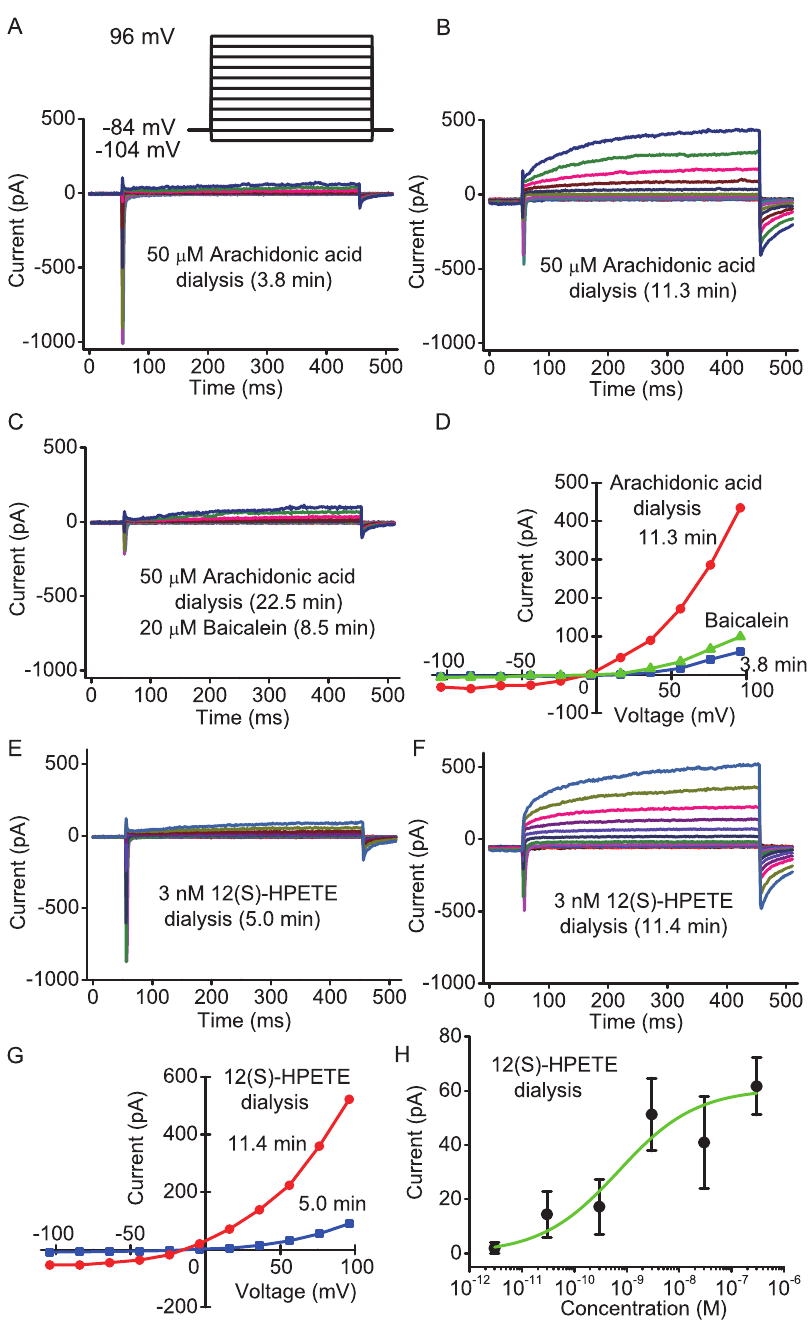
Figure 8. Biophysical properties of intracellular arachidonic acid-induced and 12(S)-HPETE-induced currents. (A) The currents elicited by 400 ms voltage steps between 2 104 to + 96 mV in 20 mV increments from a holding potential of 2 84 mV under the condition of 50 m M arachidonic acid dialysis after 3.8 min of the membrane rupture in normal saline solution. (B) The currents under same condition after 11.3 min of the rupture. (C) The currents under the condition after 8.5 min of the addition of 20 m M baicalein to external solution. (D) Current/voltage ( I/V ) relationships for the currents at the end of pulse in above conditions. (E) The currents under the condition of 3 nM 12(S)-HPETE dialysis at 5.0 min of the membrane rupture in normal saline solution. (F) The currents under same condition at 11.4 min of the rupture. (G) Current/voltage ( I/V ) relationships for the currents at the end of pulse in above conditions. (H) Dose-response relationship for intracellular 12(S)-HPETE-induced current measured at 2 54 mV. The ordinate scale denotes the absolute value of the inward current. Data were fitted by the Hill equation (Hill coefficient: 0.6). Values are mean 6 from 4–8 cells. doi:10.1371/journal.pone.0019158.g008 EC 50 of extracellular Ca 2 + for inhibition of human PTH an EC 50 of 5 mM extracellular Ca 2 + for stimulation of Ca 2 + - secretion is about 1.2 mM [41]. On the other hand, Xenopus activated Cl 2 current under the condition of resting 0.5 mM Ca 2 + [42]. In the frogs, the actual relationship between extracellular oocytes injected with cRNA prepared from bovine CaR displayed